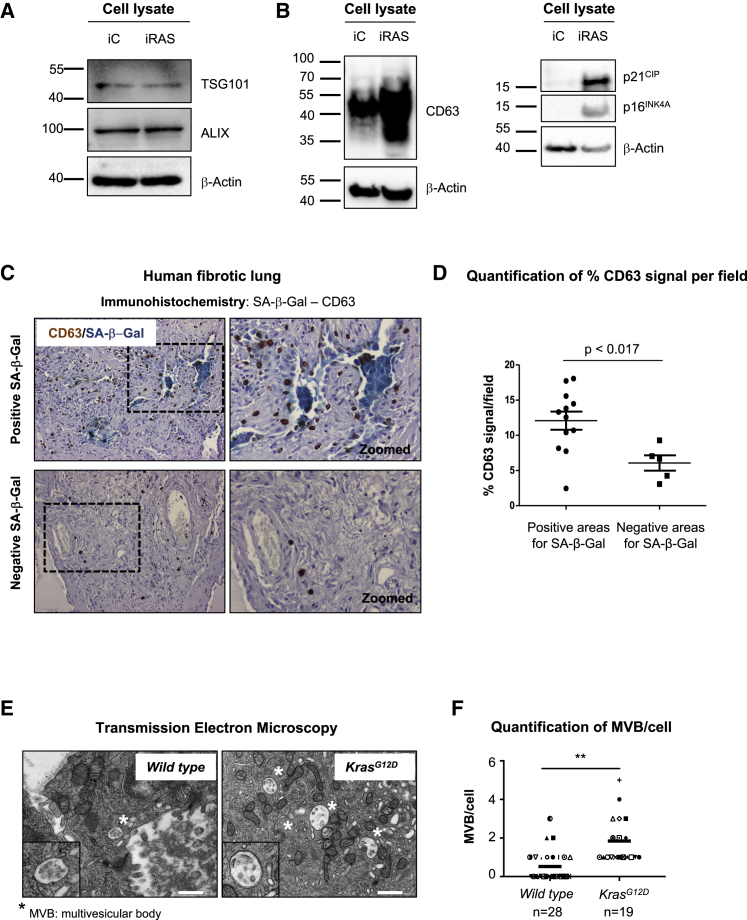
Increase in CD63 Staining and Multivesicular Body Formation during Senescence In Vivo(A and B) Immunoblot for endogenous expression of (A) ALIX and TSG101 and (B) CD63. p21CIP and p16INK4A upregulation are positive controls to confirm the induction of senescence. β-Actin represents the loading control.(C) Immunohistochemistry for SA-β-Gal (blue staining) and CD63 (brown signal) in a representative human sample of lung fibrosis. H&E staining is shown (violet). Pictures at top represent areas enriched in SA-β-Gal+ cells, and pictures at bottom show areas with low SA-β-Gal+ cells.(D) Quantification of positive pixels for CD63 per field, normalized by the H&E staining. The Mann-Whitney test was performed.(E) Representative transmission electron microscopy images of multivesicular bodies (MVBs) in wild-type (WT) and KrasG12D-derived PanIN (KrasG12D). Scale bar, 500 nm.(F) Quantification of MVB per cell in WT (n = 28 cells) and PanINs (n = 19 cells).See also Figure S4.